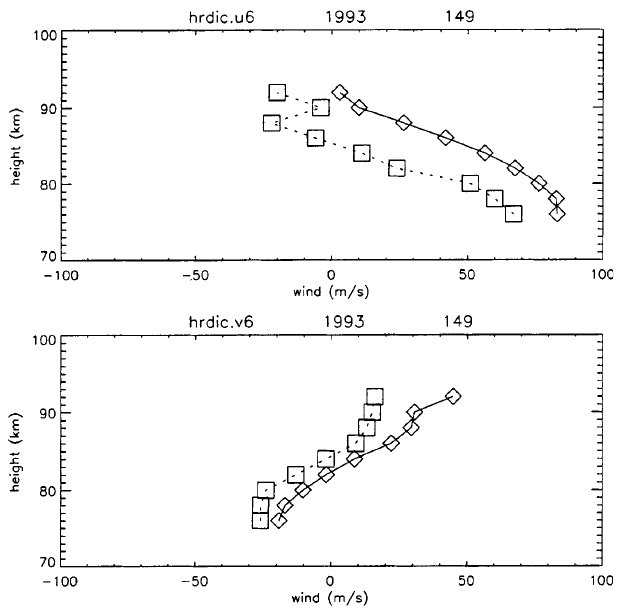
Fig. 11. Wind profiles for the individual overpass occurring on 29 May 1993: zonal wind (upper panel), meridional wind (lower panel). HRDI diamonds, radar squares